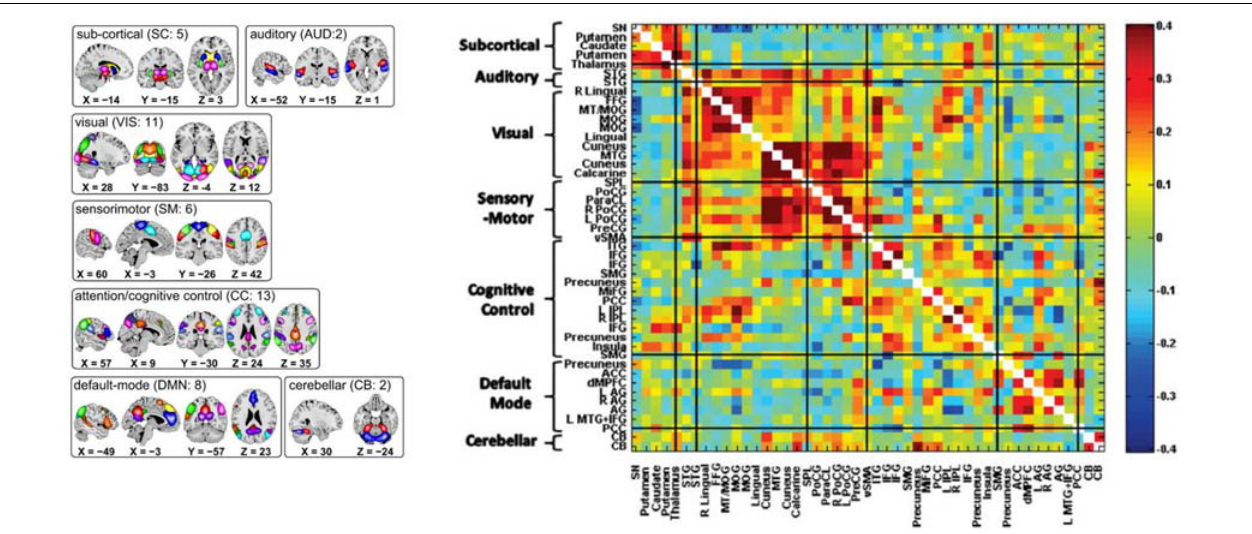
FIGURE 1 | (Left) Composite maps of the 47 resting state networks use in this study, organized according to functional domain with each network in the indicated domain shown in a different color (Damaraju et al., 2014); (Right) Population means of pairwise correlations between RSN time series. The order in which networks and functional domains (shown along the y -axis) are presented here is consistent through all figures in this paper. The functional domains, indicated by bracketed groups of networks on the y -axis, are most often displayed in abbreviated form: SC, subcortical; AUD, auditory; VIS, visual; SM, sensorimotor; CC, cognitive control; DMN, default mode network; and CB,